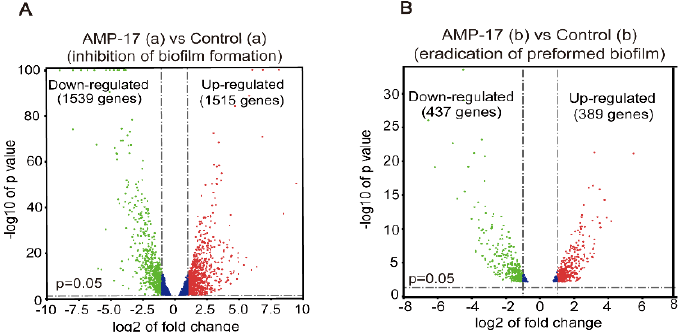
Figure 6. The effect of AMP-17 on the transcriptional profiling of biofilms in C. albicans . ( A ) The volcanic map analysis of DEGs in C. albicans biofilm formation after 12 h of treatment with 32 µ g/mL AMP-17. ( B ) The volcanic map analysis of DEGs in preformed C. albicans biofilm after 12 h of treatment with 128 µ g/mL AMP-17. “a” in the above Figure indicates early forming biofilm (12 h), while “b” indicates preformed biofilm.